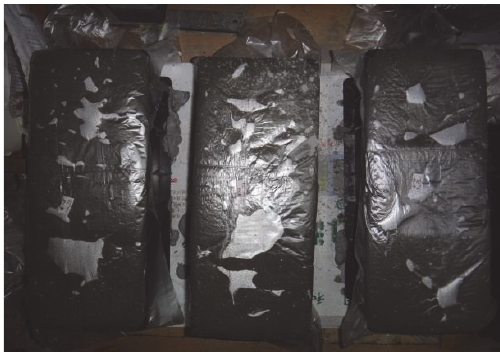
Figure 3: Samples before demoulding.